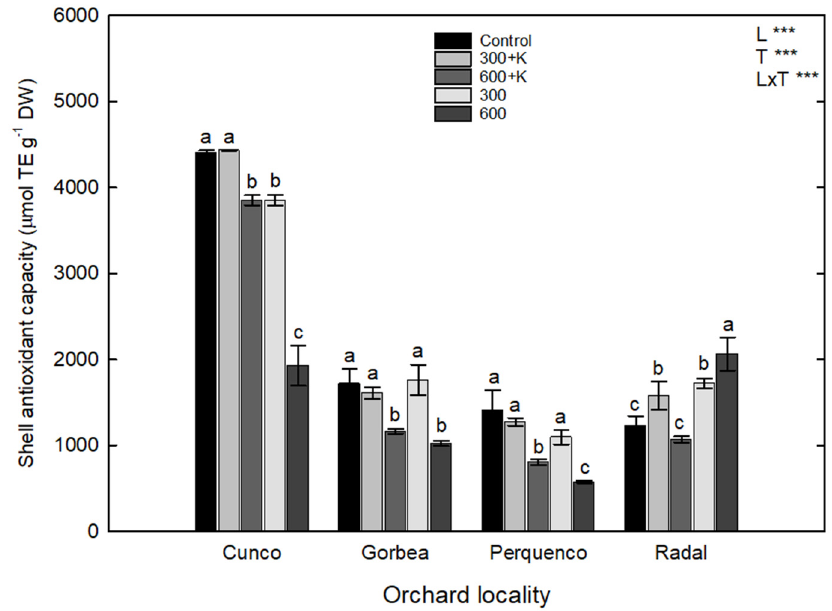
Figure 5. Antioxidant capacity ( µ mol TE g − 1 DW) of the shells of TDG hazelnuts after the foliar spraying of Ca, Mg and K in four orchards in the La Araucanía region. Bars represent the average of four replicates ± S.E. Different letters indicate statistical differences ( p ≤ 0.05) between treatments in the same locality. Two-way ANOVA results are shown; *** p < 0.001. Control (water), 300+K (Ca+Mg+K at 300 mg L − 1 ), 600+K (Ca+Mg+K at 600 mg L − 1 ), 300 (Ca+Mg at 300 mg L − 1 ), and 600+K (Ca+Mg at 600 mg L − 1 ).